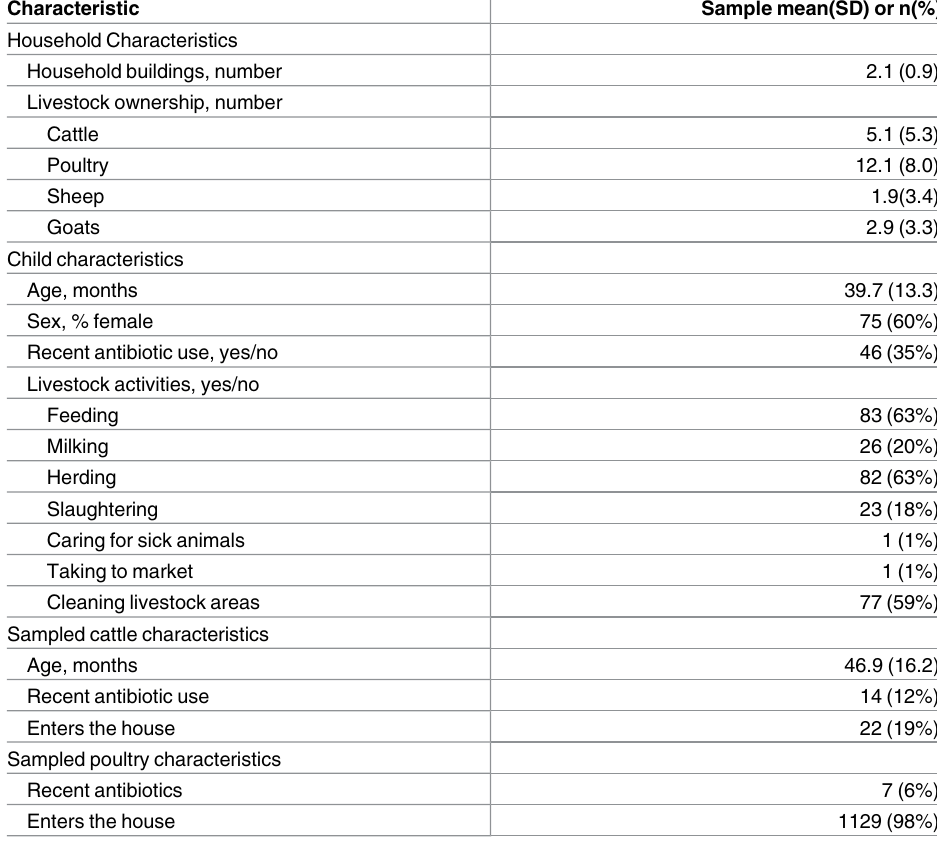
Table 1. Characteristics of sampled households, children, cattle, and poultry, western Kenya 2014 (n = 117 households).